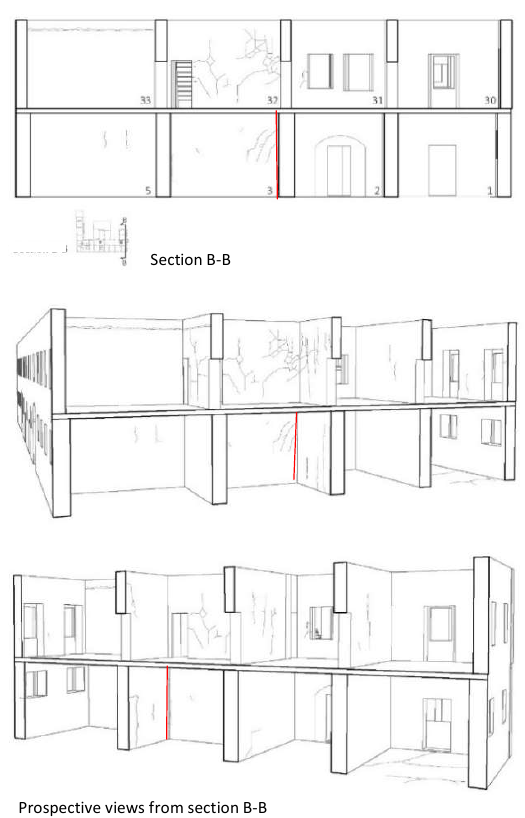
Figure 5. Example of crack pattern (in red a crack probably due to lack of connection between two blocks built in different construction periods).